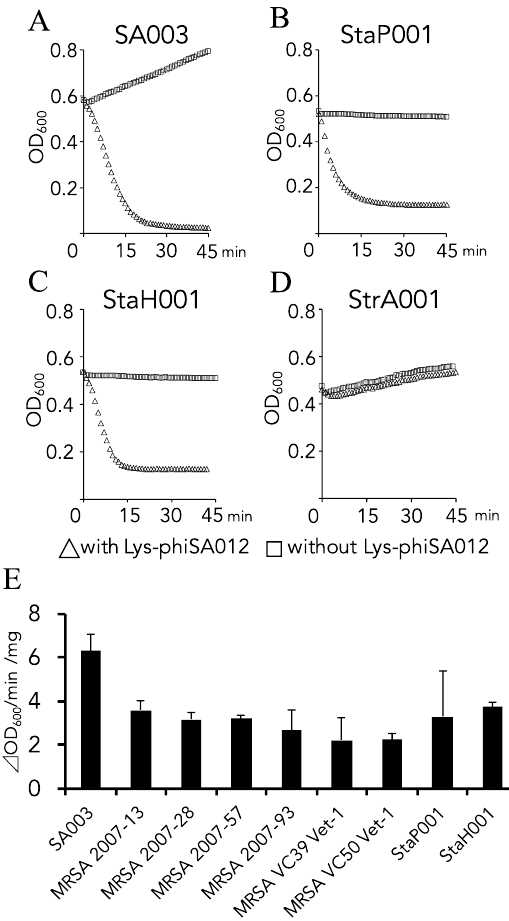
Figure 2. Antimicrobial spectrum of Lys-phiSA012. Lytic activities towards SA003, StaP, StaH, StrA and MRSA were examined using a turbidity reduction assay, as described in the materials and methods section. SA003 was isolated from bovine milk and has been reported to be susceptible to phiSA012 [28]. SA003 was also used in a mouse mastitis model [29]. MRSA strains were isolated from veterinarians and staff members of veterinary clinics [48,49]. Lys-phiSA012 ( A ) 109 µg/mL, ( B ) 132 µg/mL, ( C ) 132 µg/mL and ( D ) 106 µg/mL was added to the bacterial cultures. The values of OD 600 were plotted each minute. ( E ) Lytic activities towards staphylococcal strains were examined. The maximum rate for each reaction is represented as ∆OD 600 min − 1 mg − 1 , calculated as previously reported [61] and presented as means ± standard deviation (SD).